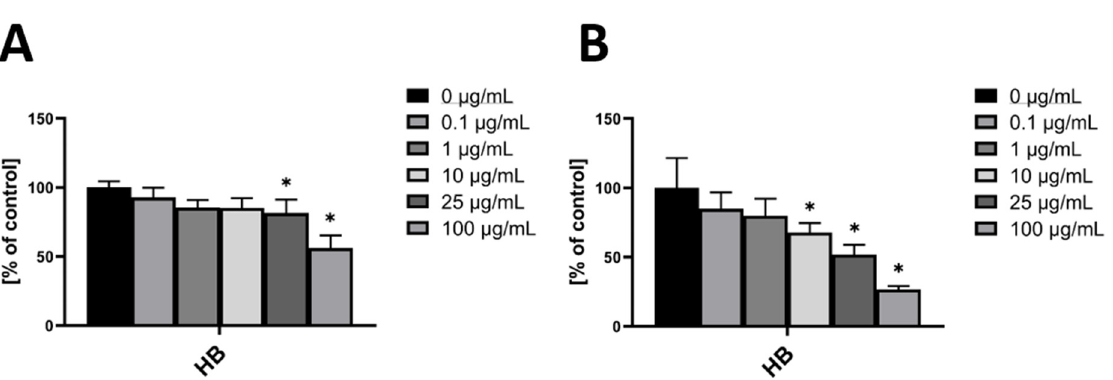
Figure 1. DCF-DA fluorescence relative to control with the respective concentrations of HB in HUVEC ( A ) and hmvEC ( B ); results are expressed as mean ± SD; * p < 0.05 compared to 0 µg/mL HB; n = 4 technical replicates.